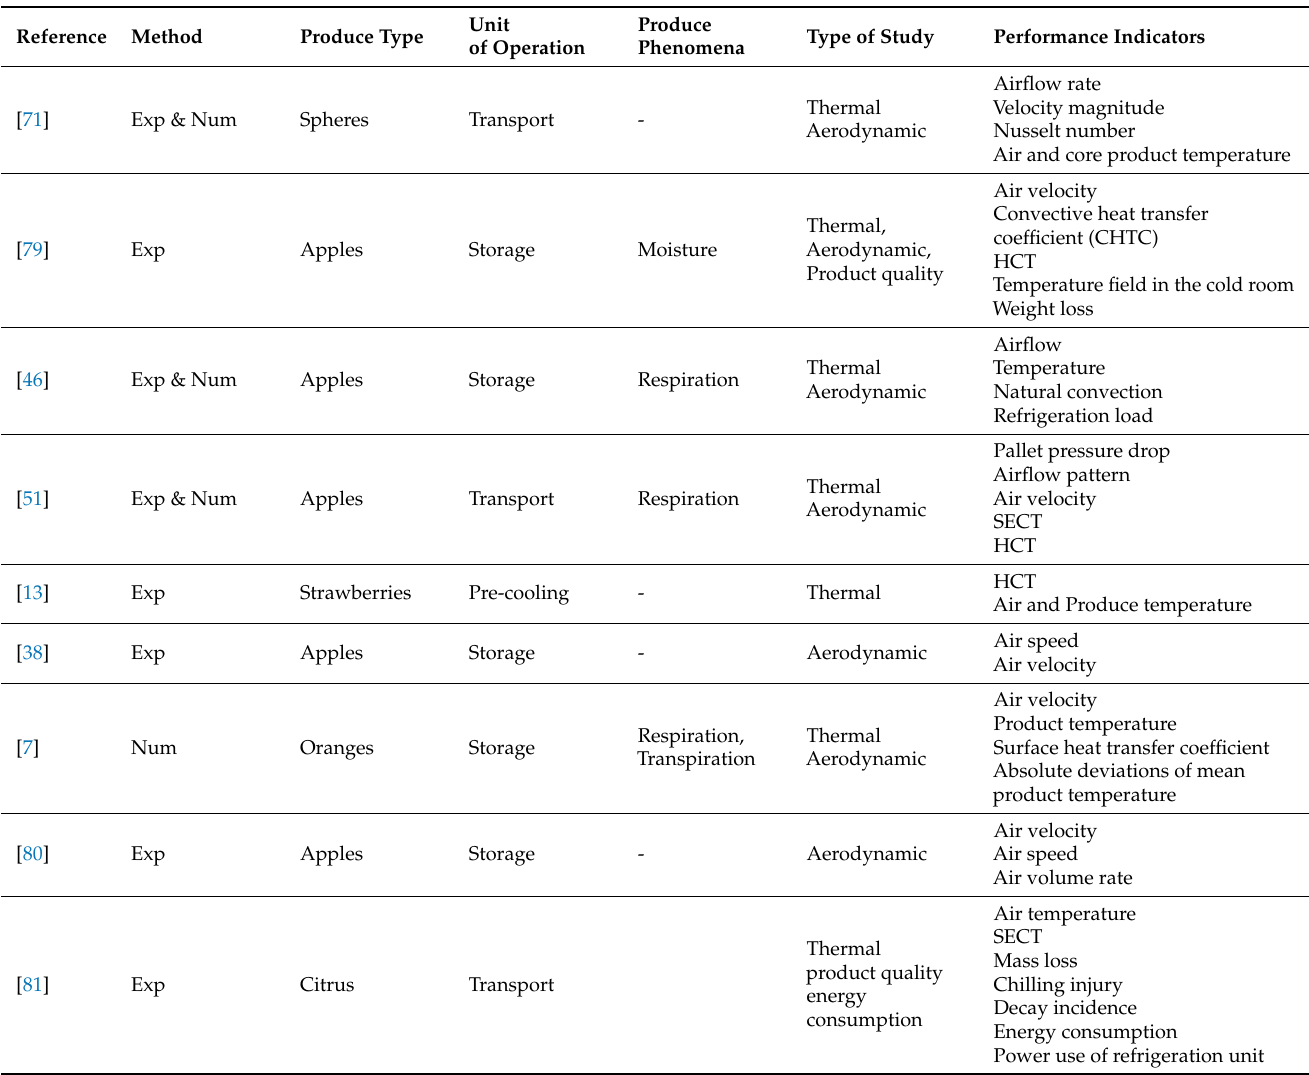
Table 2. Studies investigating the airflow pattern and temperature distribution around pallets inside a cooling